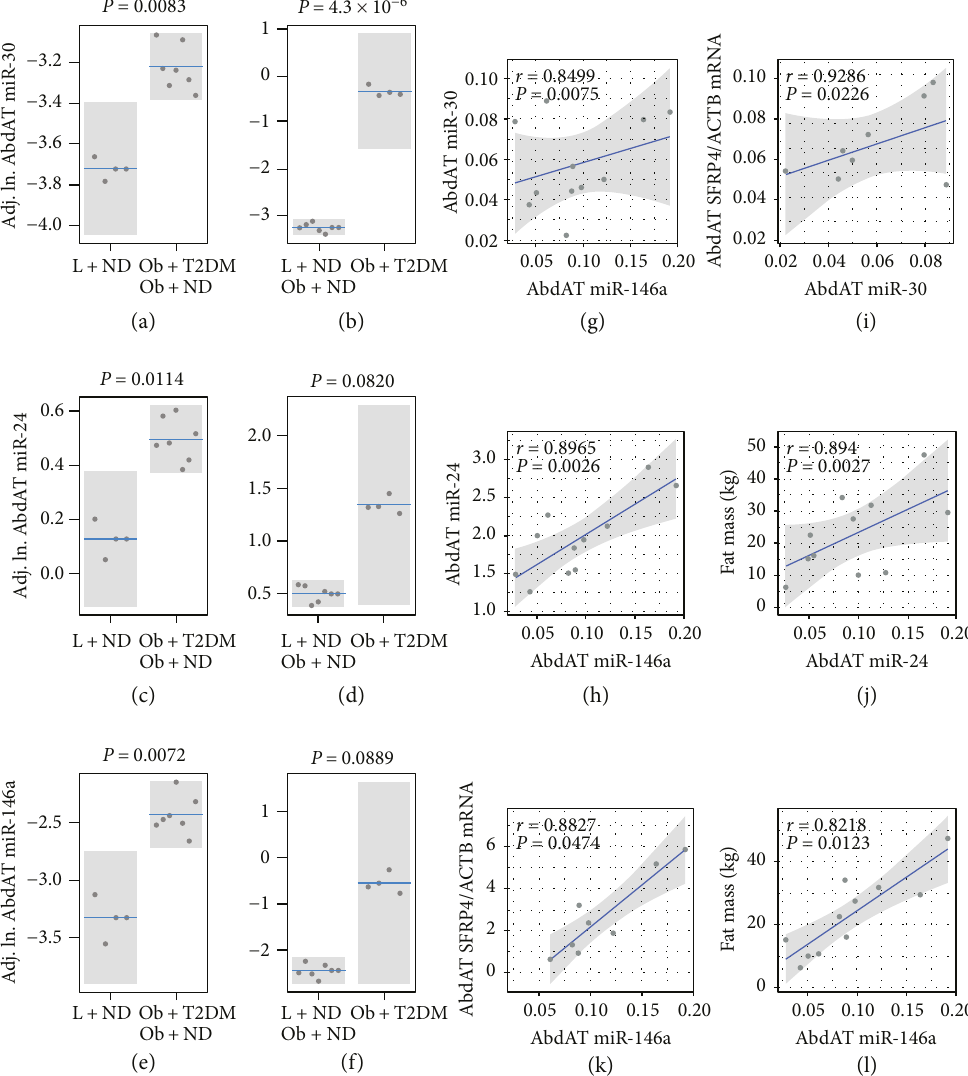
Figure 1: Di ff erential expression and correlation analysis identify key coexpressed abdominal adipose tissue (AbdAT) miRNAs that appear to interact with AbdAT SFRP4. AbdAT miRNAs measured by qRT-PCR are elevated in subjects with obesity and diabetes (a – f). Levels of select miRNAs, mRNAs, and proteins in AbdAT were modeled using generalized linear models (GLMs with a gamma family and log link) as a function of a T2DM-related variable with two levels (ND, T2DM) and a BMI-related variable with two levels (lean, obesity). GLMs controlled for potential confounders including age, gender, and ethnicity. Visualization of the regression models was rendered with the R package visreg . Boxplots with overlapped dot plots display the adjusted values (partial residuals). Mean represented by the blue line and 95% con fi dence interval of the mean as a grey band. ND: subjects without type 2 diabetes; T2DM: subjects with type 2 diabetes; Adj. ln: natural logarithm value of the measurement adjusted for confounders including age, gender, and ethnicity. Partial correlation analysis identi fi ed seemingly coregulated miRNAs and signi fi cant associations between speci fi c AbdAT miRNAs and AbdAT SFRP4 and measures of adiposity (g – l). Correlation scatterplots including miRNA variables display the − Δ Ct data from di ff erentially expressed AbdAT miRNAs and were generated with the R package ggplot2 . The reported partial correlation that controlled for age, gender, and ethnicity was calculated with the ppcor package. The blue line and gray band represent the linear fi t of the plotted values and the 95% con fi dence interval of the fi t, respectively. The secondary analysis of miRNA expression in abdominal adipose tissue was performed in seventeen subjects (lean N = 7 and subjects with obesity N = 10 ), as per sample